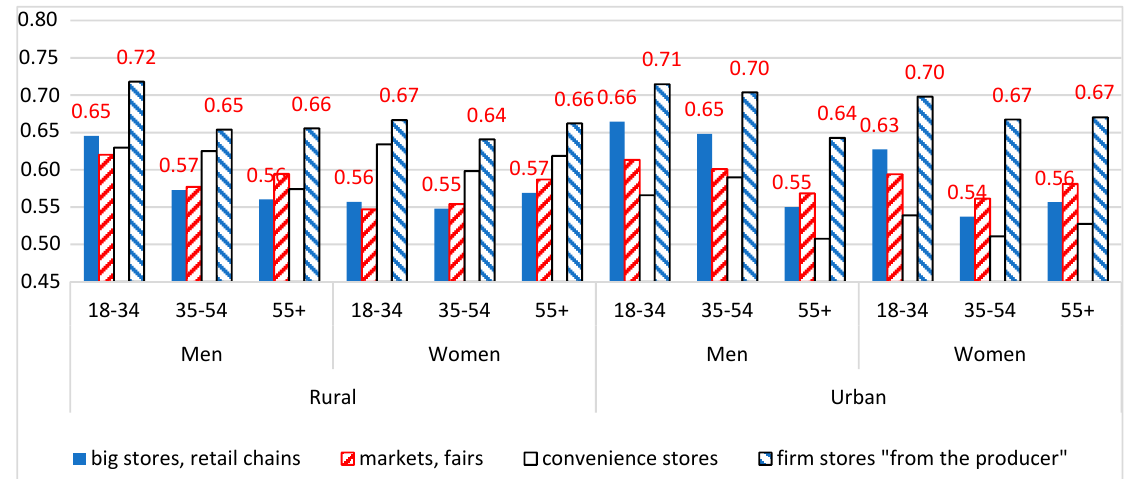
Figure 2. Average index of trust in regional sales operators in terms of food quality and safety for settlement type, gender and age. Source: authors’ research.